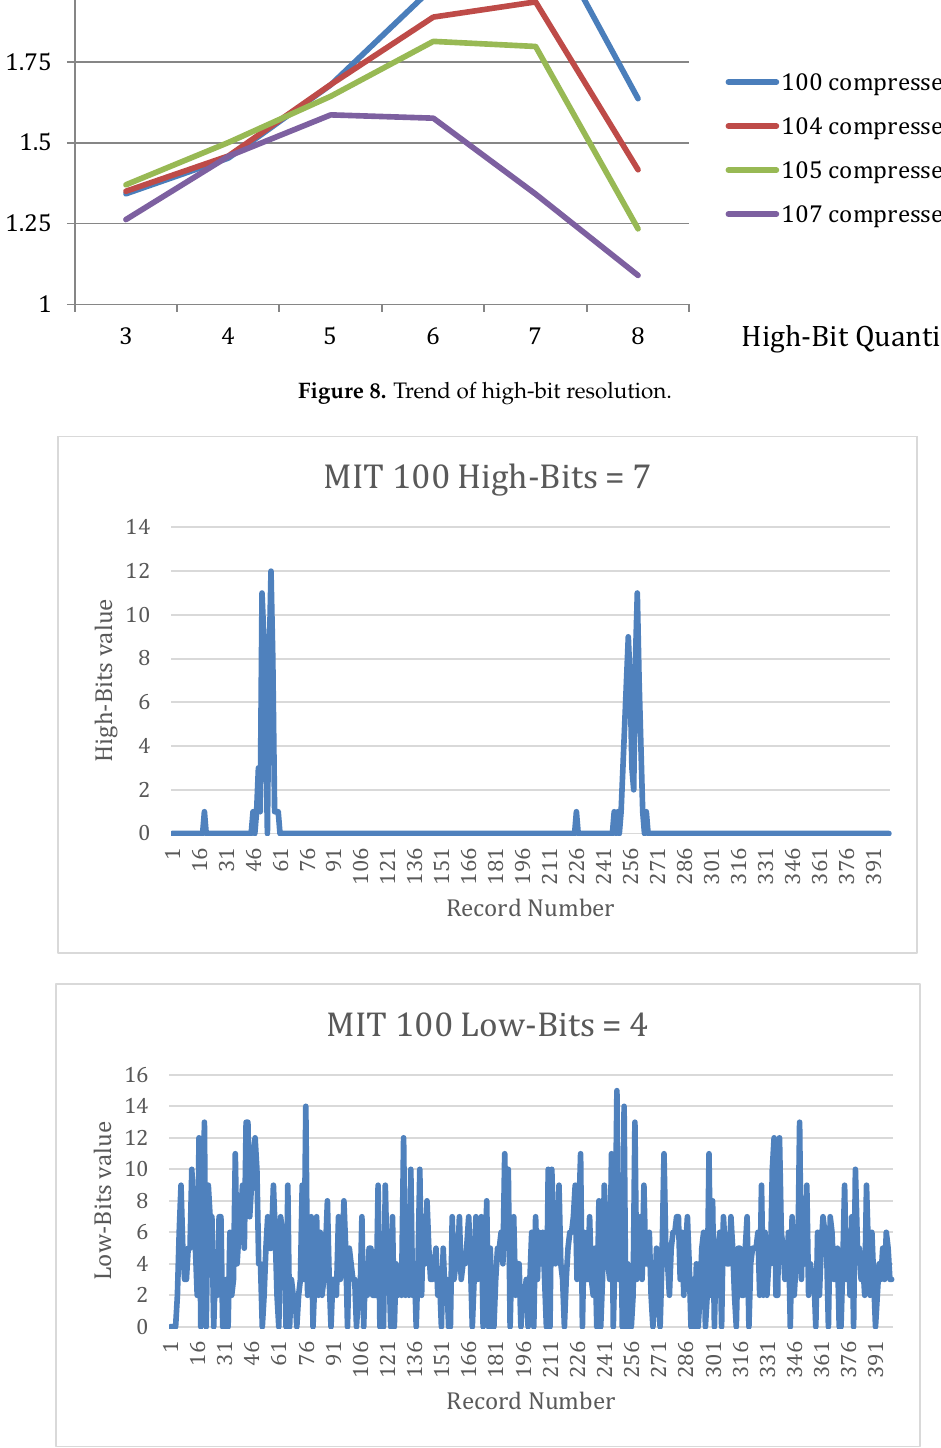
Figure 9. Best case: MIT/BIH Arrhythmia Database recording 100 high bits = 7.